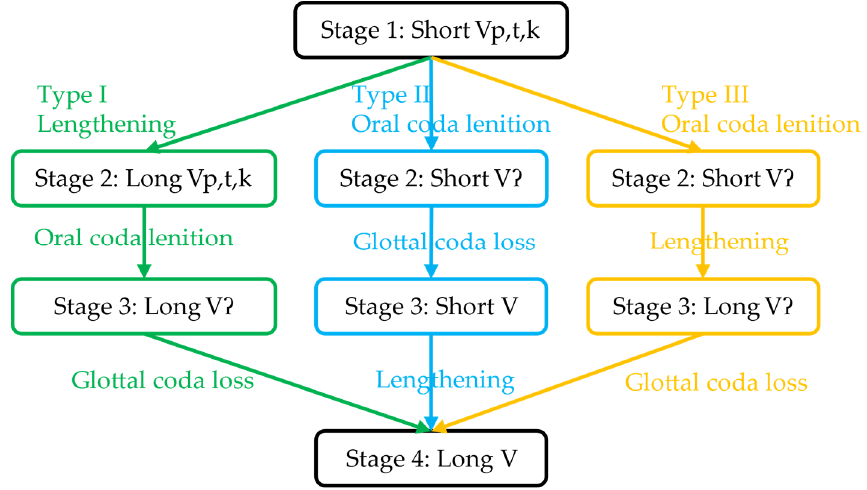
Figure 14. Three paths involving the loss of checkedness (schematized based on Zhu et al. (2008)). The differences in the three paths depend on the sequencing of vowel lengthening, oral coda lenition, and glottal coda loss. Given how common it is for Chinese languages to lose their checked tones, one might assume that the checked syllables in Xiapu Min